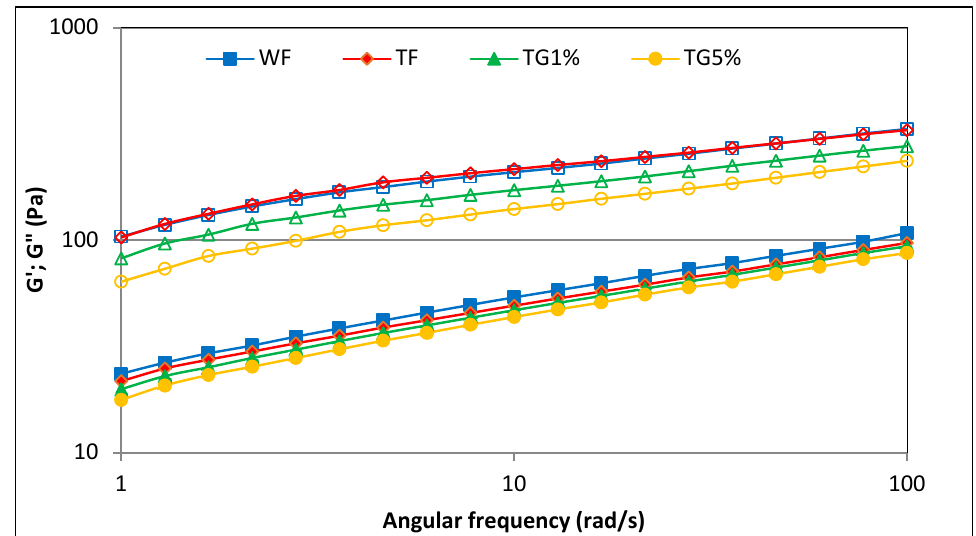
Figure 5. Mechanical spectra of wheat flour, triticale flour and system of triticale flour with vital gluten. G ′ —empty markers; G ″ — fi lled markers.